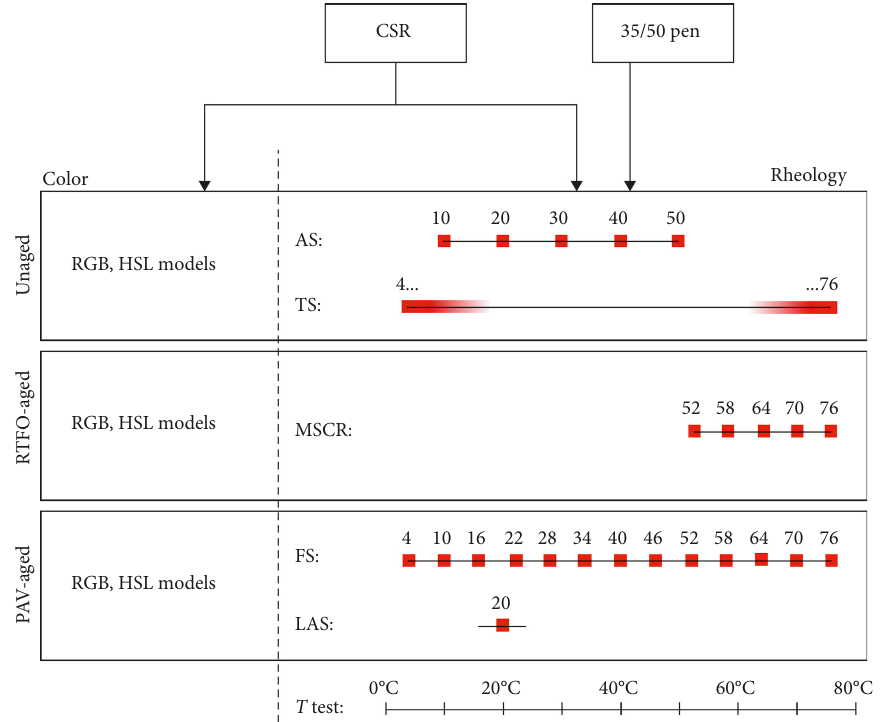
Figure 6: Summary of the experimental plan.